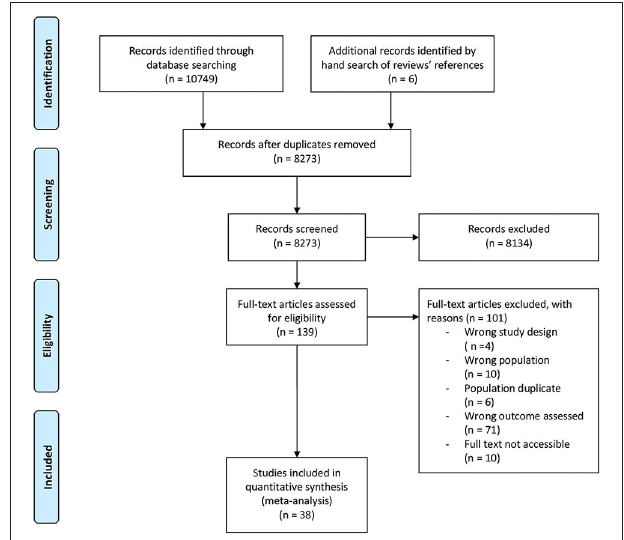
FIGURE 1 | Flow diagram of study selection process for